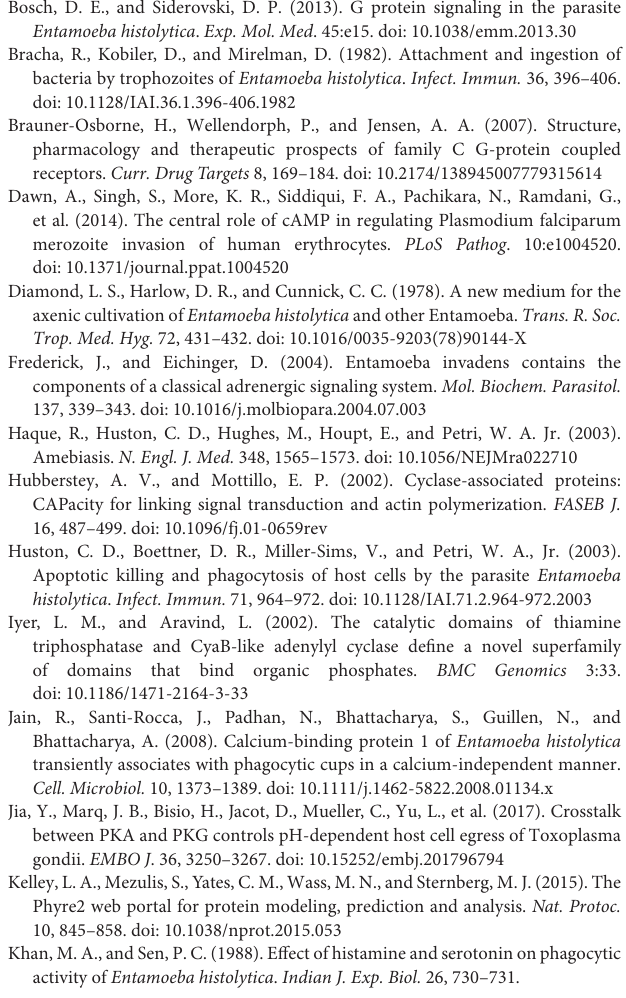
Supplementary Figure 1 | Evolutionary relationship of Carbonic anhydrase. The evolutionary history of the enzyme carbonic anhydrase from E. histolytica was traced using the same enzyme from other organisms. The organisms included in the study were Hs, Homo sapiens ; Dm, Drosophila melanogaster ; Dd, Dictyostelium discoideum ; Sc, Saccharomyces cerevisiae ; Ld, Leishmania donovani . The amoebic enzyme (Blue) related more with the lower eukaryotes than with the human homolog. Supplementary Figure 2 | Erythrocyte uptake assay for phagocytosis. E. histolytica cells incubated with RBCs for the indicated time points (0–50min) were assessed for RBC uptake by spectrophotometric analysis. The experiments were repeated independently three times in duplicate with error bars indicating the standard